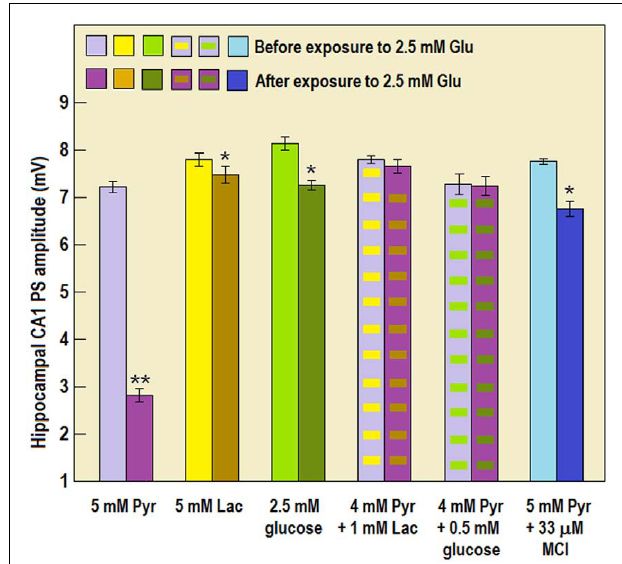
FIGURE 9 |The mean, electrically evoked, population spike (PS, neuronal function) amplitude in rat hippocampal slices perfused for at least 45min with aCSF containing either 5mM pyruvate (Pyr), 5mM lactate (Lac), 2.5mM glucose, 4mM Pyr + 1mM Lac, 4mM Pyr + 0.5mM glucose, or 5mM Pyr + 33 μ M MCI-186 (MCI) in the absence or presence of 2.5mM Glut. Pyruvate alone could not sustain neuronal function in the presence of Glut. Pyruvate inability to sustain normal neuronal function during exposure to Glut appears to be in contrast to the results shown in Figure 6 . However, the difference stems from the fact that in this set of experiments slices were exposed to Glut for 45min, while in the experiments described in Figure 6 they were exposed to Glut for only 20min. All other treatments overcame the excitotoxicity of Glut. Each column is the mean PS amplitude recorded from at least 23 slices prepared from at least three different rat brains. Bars are SE of the mean. *Significantly different from the PS amplitude in control slices not exposed to Glut ( p < 0.004); **significantly different from the PS amplitude in control slices not exposed to Glut ( p <